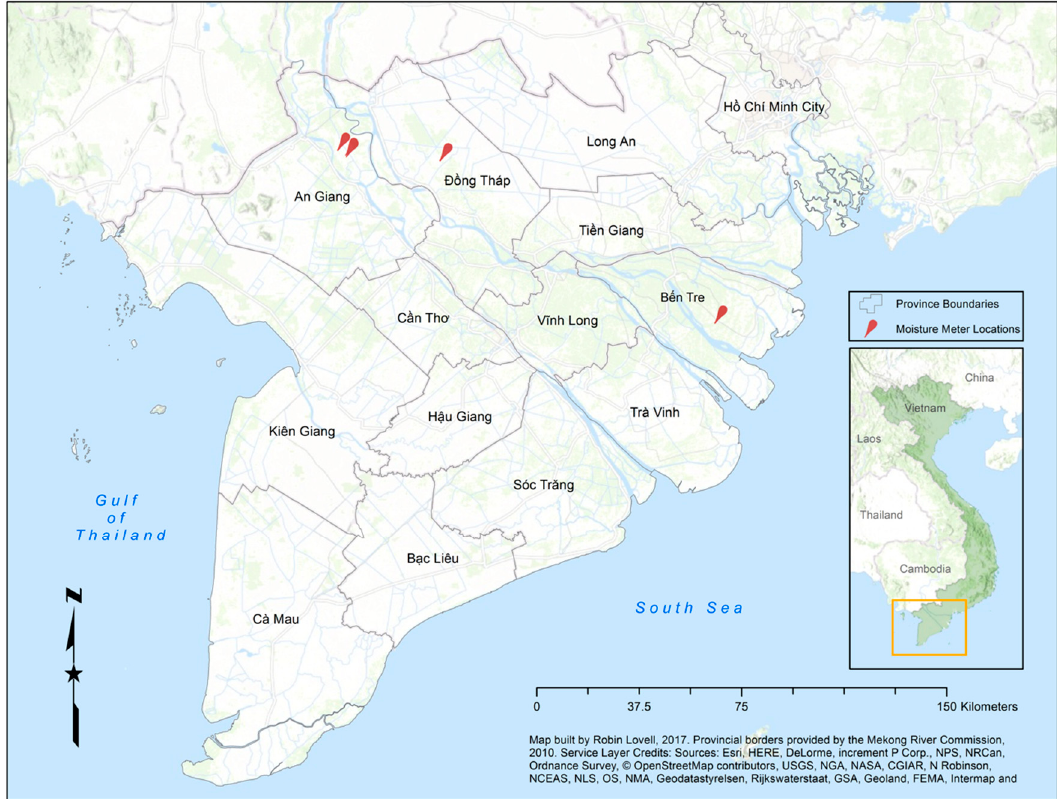
Figure 2. Study Location Map. Test plots and soil moisture meter locations are shown in red. Two test plots were chosen in each province, an alternative wetting and drying (AWD) and non-AWD rice paddy, representing the three major soil types in the delta. An Giang Province is alluvial soils, Ben Tre Province is saline, and Dong Thap Province is acid-sulfate. Note: the two plots are somewhat separated in An Giang, while they are very close together in Dong Thap and Ben Tre, so they display as a single point in the latter two provinces.